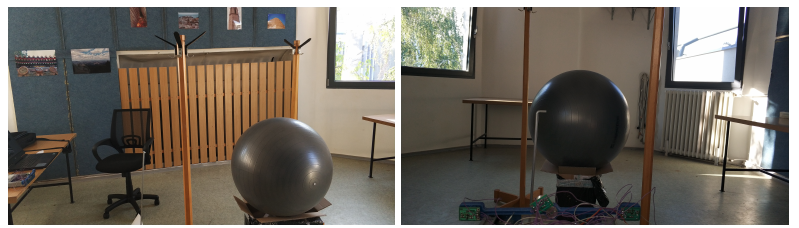
Figure 19. Indoor test No. 3.